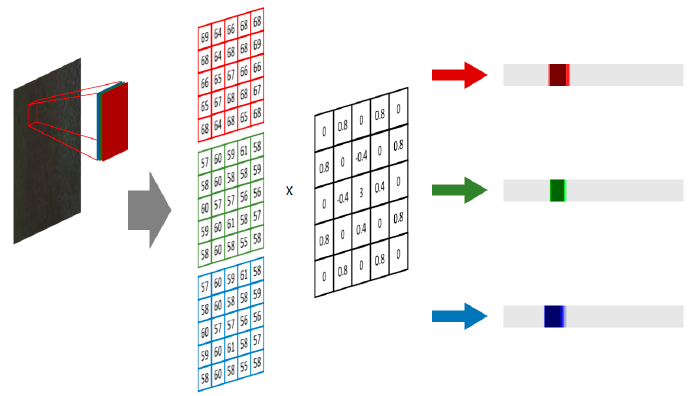
Figure 7. The extraction method of feature values.